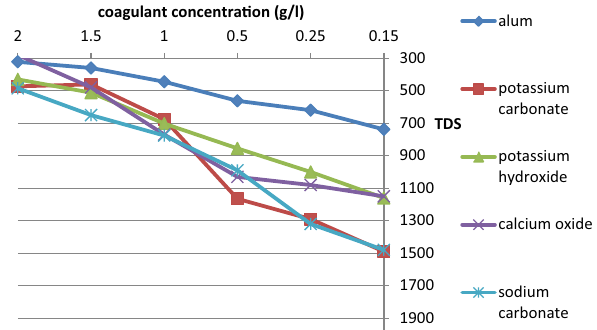
Fig. 2 TDS at varying doses of coagulants (pH